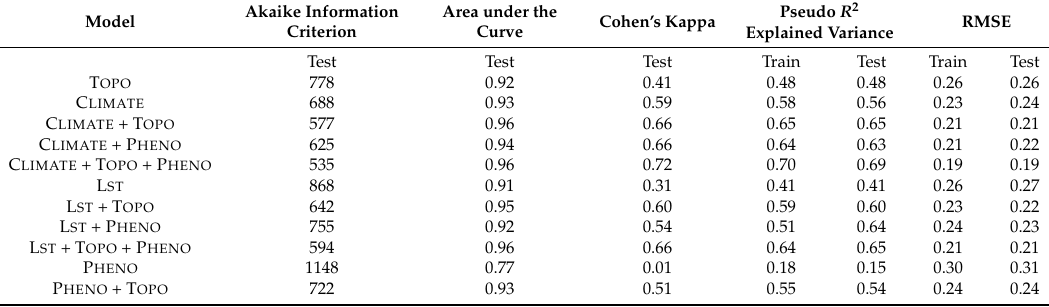
Table 2. Model evaluation results with regard to several performance measures for five averaged generalized linear model runs based on the four predictor variable sets and their combinations: Topography (T OPO ); Chelsa climate data (C LIMATE ); Land Cover Dynamics data (P HENO ); Land Surface Temperature (L ST ). The results for training and test data are displayed (training 80% and testing 20%, means of 5